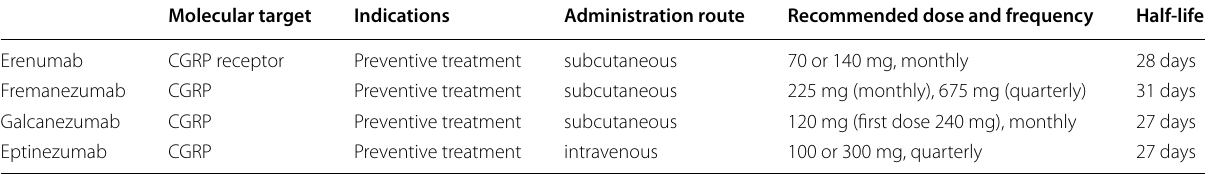
Table 2 General and pharmacokinetic characteristics of CGRP(‑receptor) targeted mAbs [89]. Abbreviations: CGRP related peptide; mAbs monoclonal =